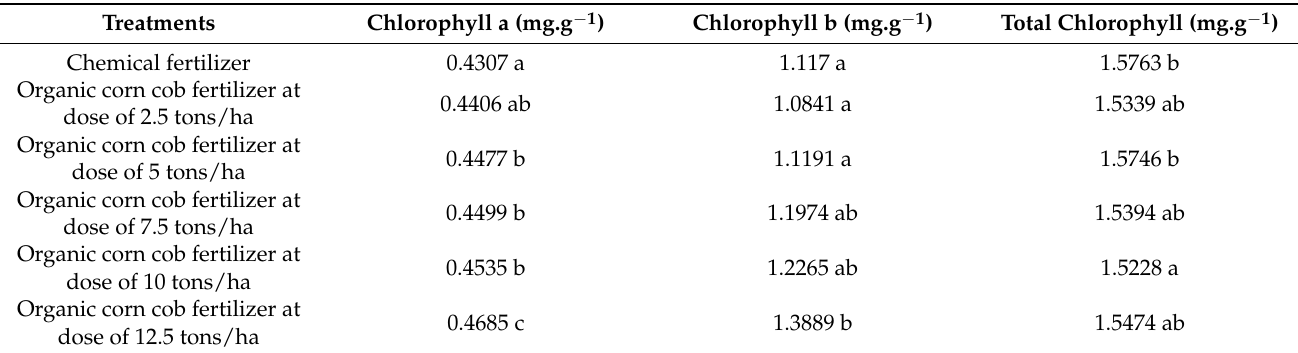
Table 3. The role of various doses of corn cob compost on chlorophyll